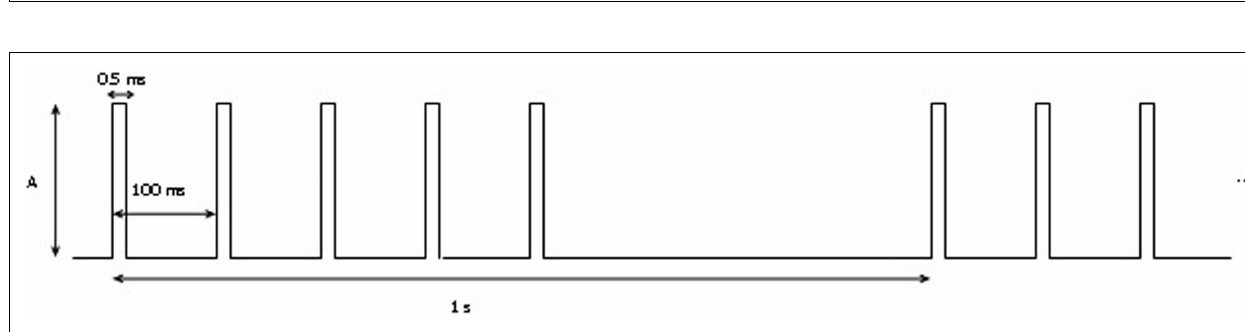
FIGURE 6 | Impedence in each electrode: with increasing of frequency, the values of impedance exhibited a general decrease, which is a characteristic behavior for a general electrode–electrolyte interface .